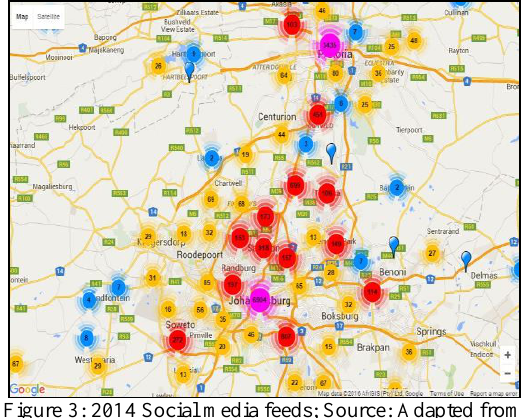
Figure 3: 2014 Social media feeds; Source: Adapted from Echo social